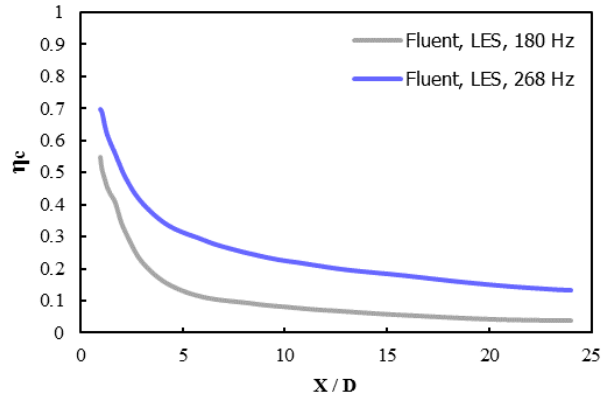
Figure 20. The centerline effectiveness obtained using the LES Smagorinsky–Lilly model for M = 0.5 for the 180 and 268 Hz oscillations [28]. Inventions 2018 , 3 , x FOR PEER REVIEW 20 of 33